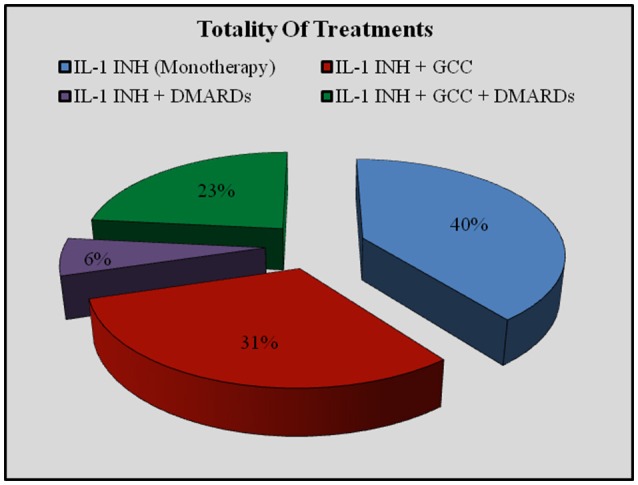
Use of concomitant therapies during IL-1 inhibition on the whole of treatment courses. DMARDs, disease modifying antirheumatic drugs; GCC, glucocorticosteroids; IL-1-INH, IL-1 inhibitors.